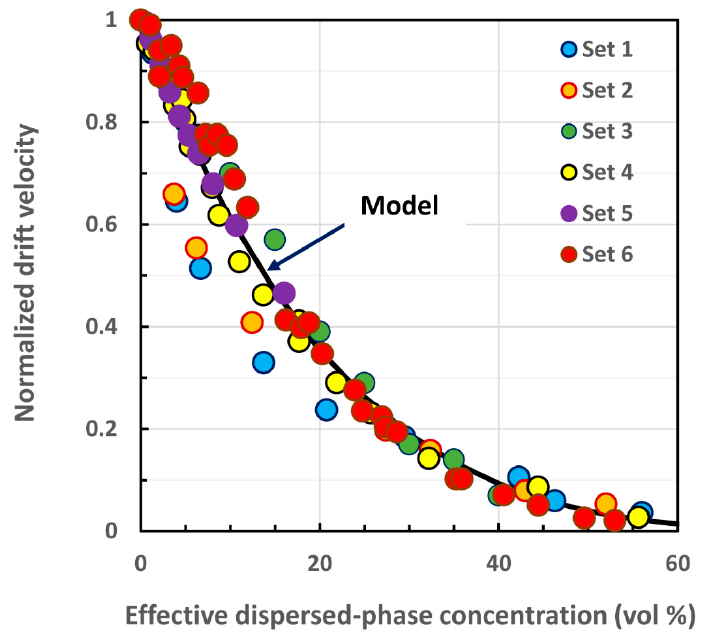
Figure 7. N ormalized drift velocity versus effective volume fraction of particles/droplets 𝜙 (cid:3032)(cid:3033)(cid:3033) . Figure 7. Normalized drift velocity versus e ff ective volume fraction of particles / droplets φ